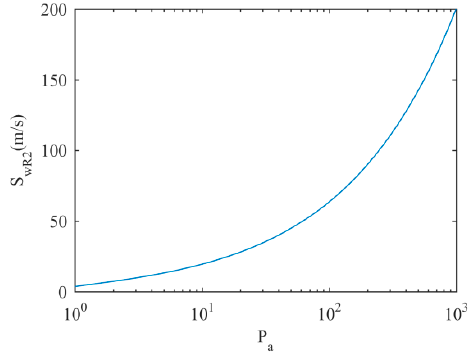
Figure 11. S wR2 under different values of P a .